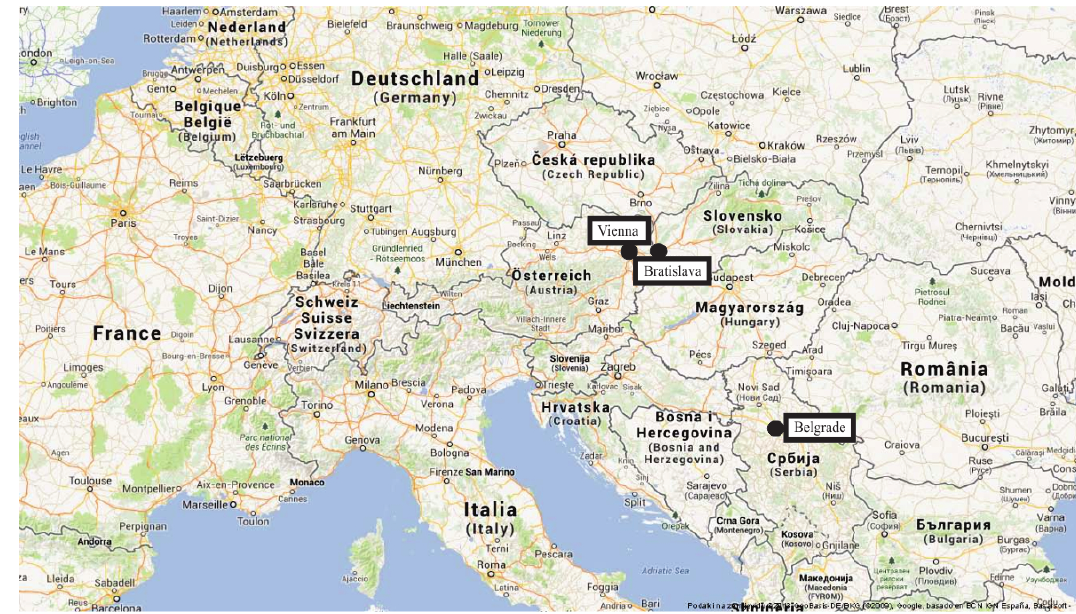
Fig. 1. Map of the case studies.